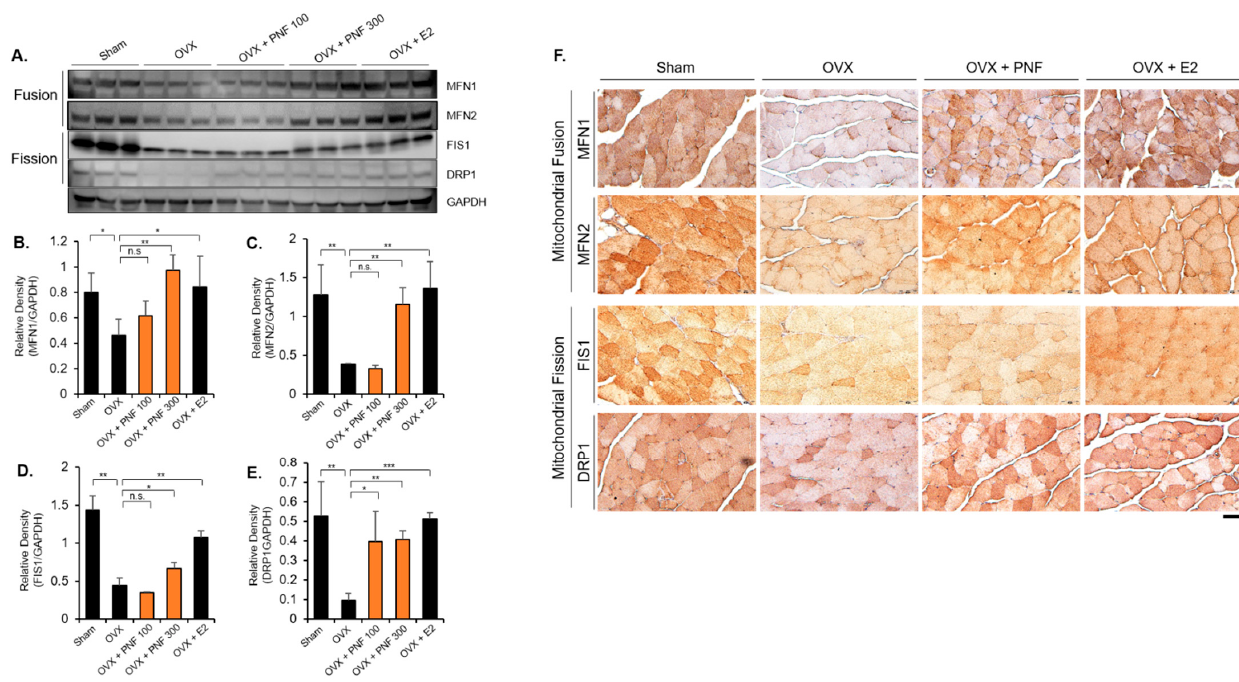
Figure 6. Dysregulated mitochondrial fission and fusion markers are recovered by PNF in TA muscle of OVX mice: ( A ) Immunoblotting was performed using proteins extracted from TA muscle. GAPDH was used as an internal control. n = 3. ( B – E ) Relative densitometric quantification of MNF1, MFN2, FIS1, and DRP1 levels from three independent experiments after normalization to GAPDH. Results are represented as relative percentages ( n = 3). ( F ) Representative immunohistochemical staining of MFN1, MFN2, FIS1, and DRP1 in TA muscle. PNF was tested at 300 mg/kg/day on OVX mice. E2 was used a positive control. MFN1 and MFN2 indicate markers of mitochondrial fusion. FIS1 and DRP1 indicate markers of mitochondrial fission. n = 5 for each group. Magnification ×40, Scale bar, 50 µm. * p < 0.05, ** p < 0.01, and *** p < 0.001. N.S., not significant.